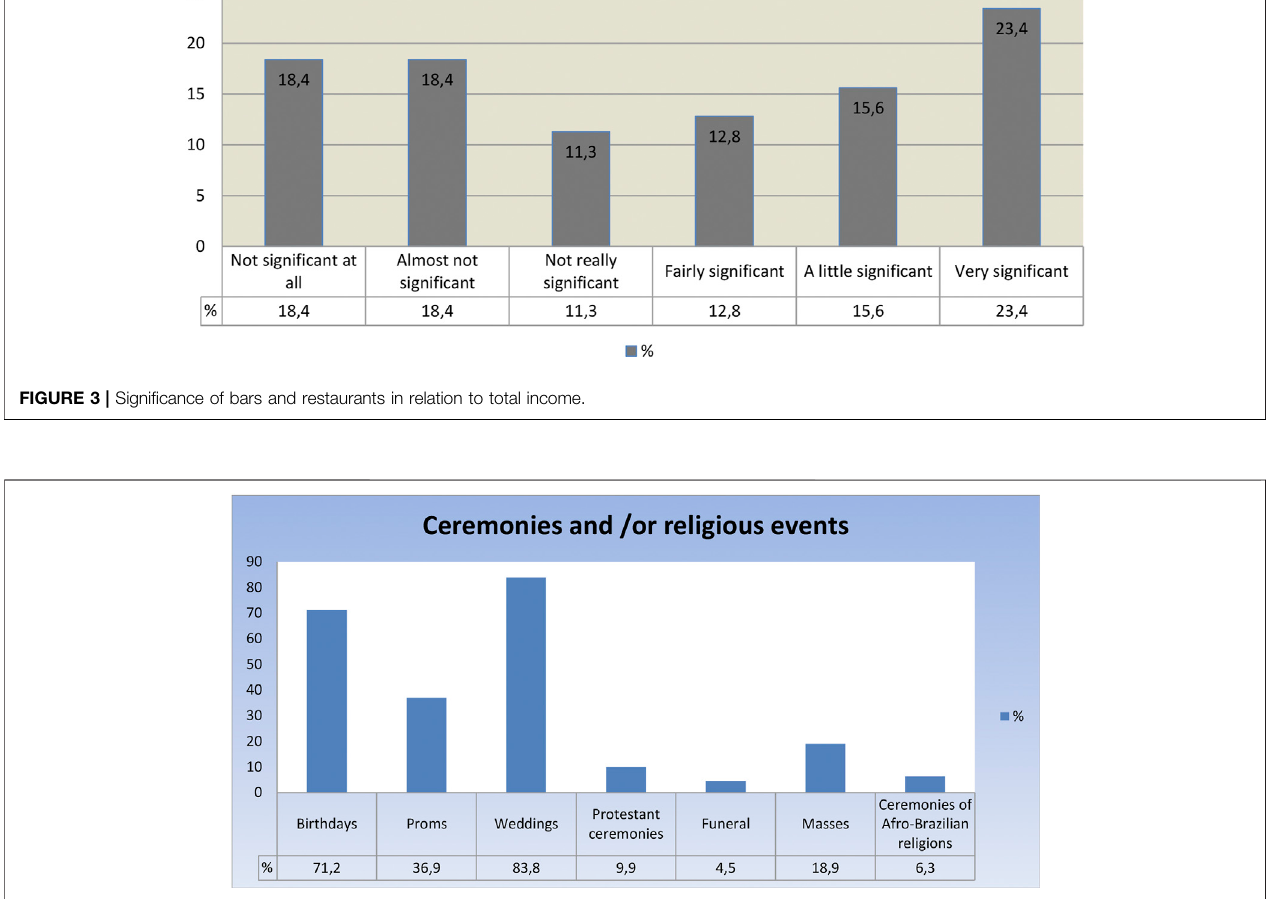
FIGURE 4 | Ceremonies and-or religious